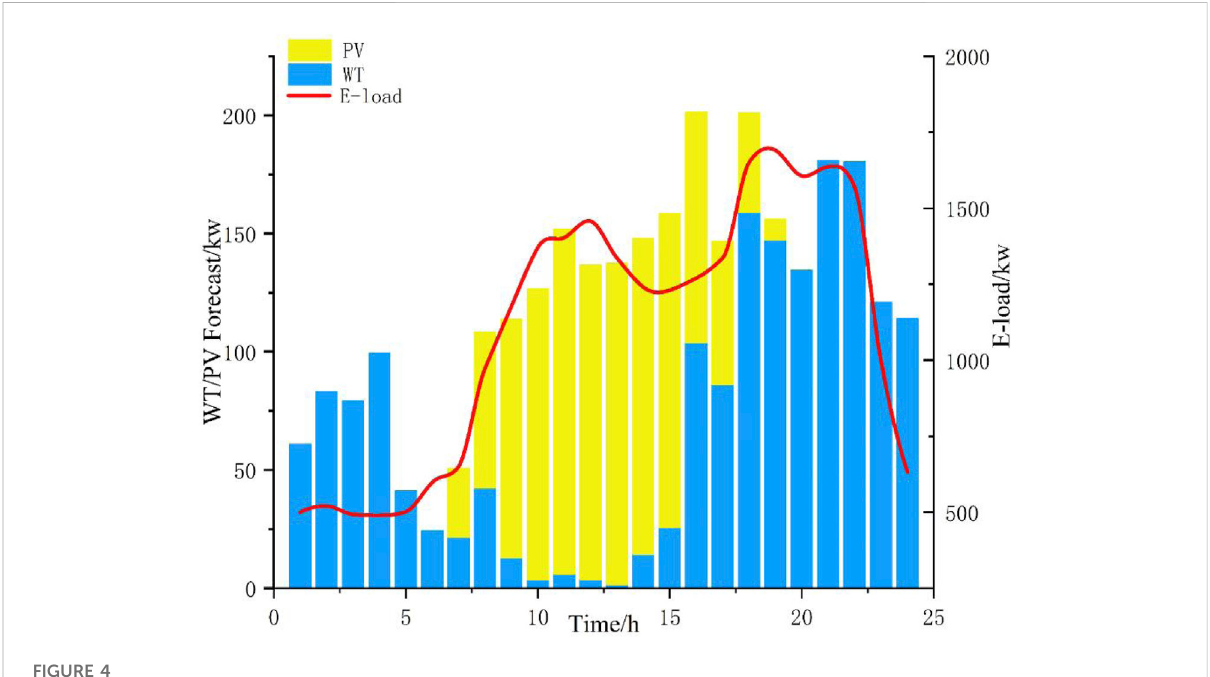
FIGURE 4 Load and new energy forecast